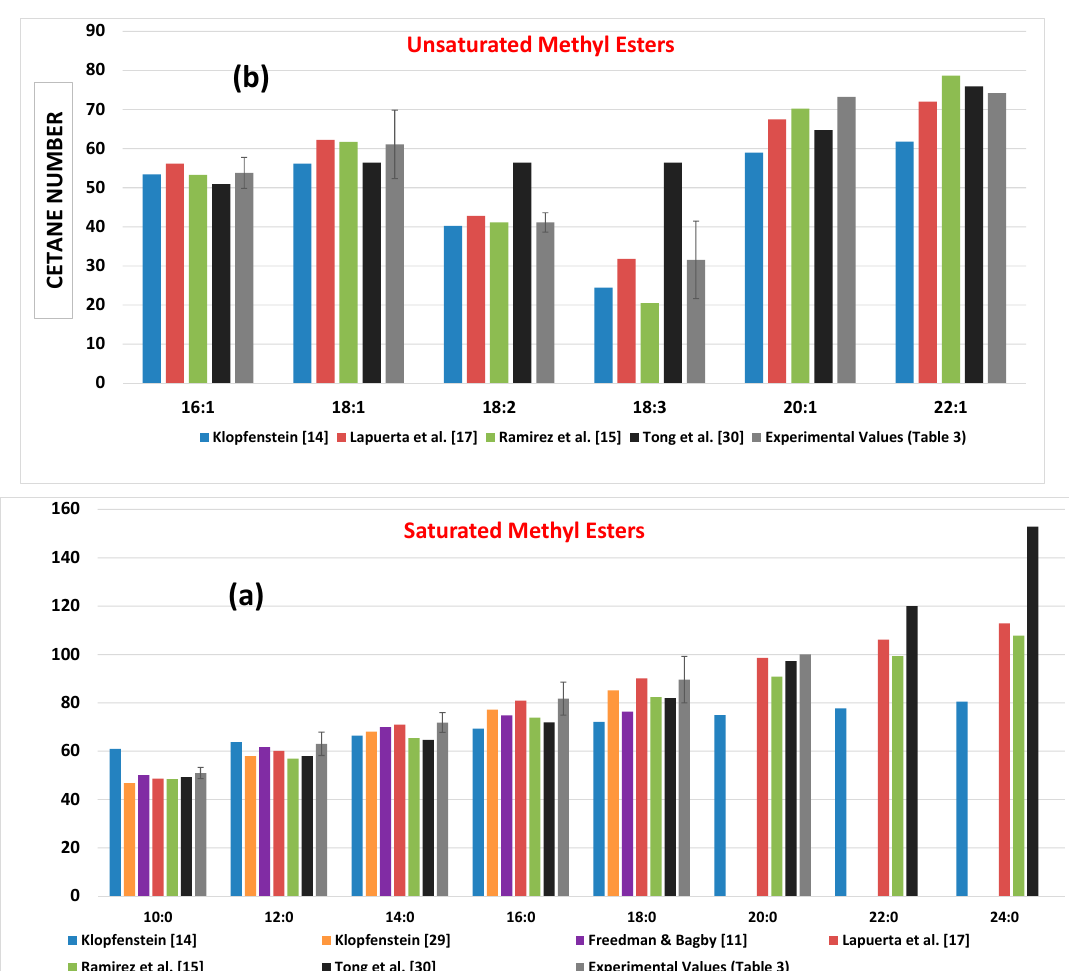
Figure 3. Predicted cetane numbers of pure FAMEs from the equations of Section 3.3, compared to average experimental values from the literature, showing also standard deviations for the experimental values: ( a ) saturated methyl esters; ( b ) unsaturated methyl esters.